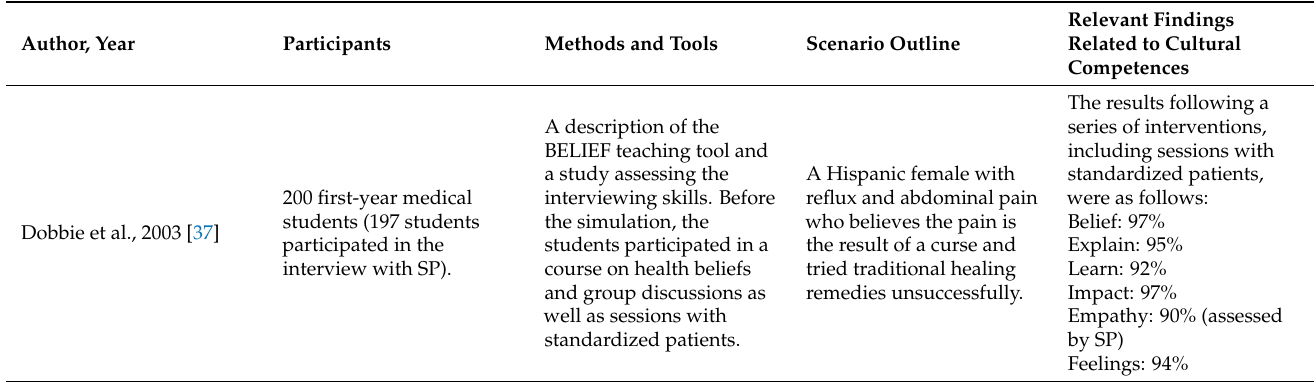
Table 2. Descriptive summary of studies on medical